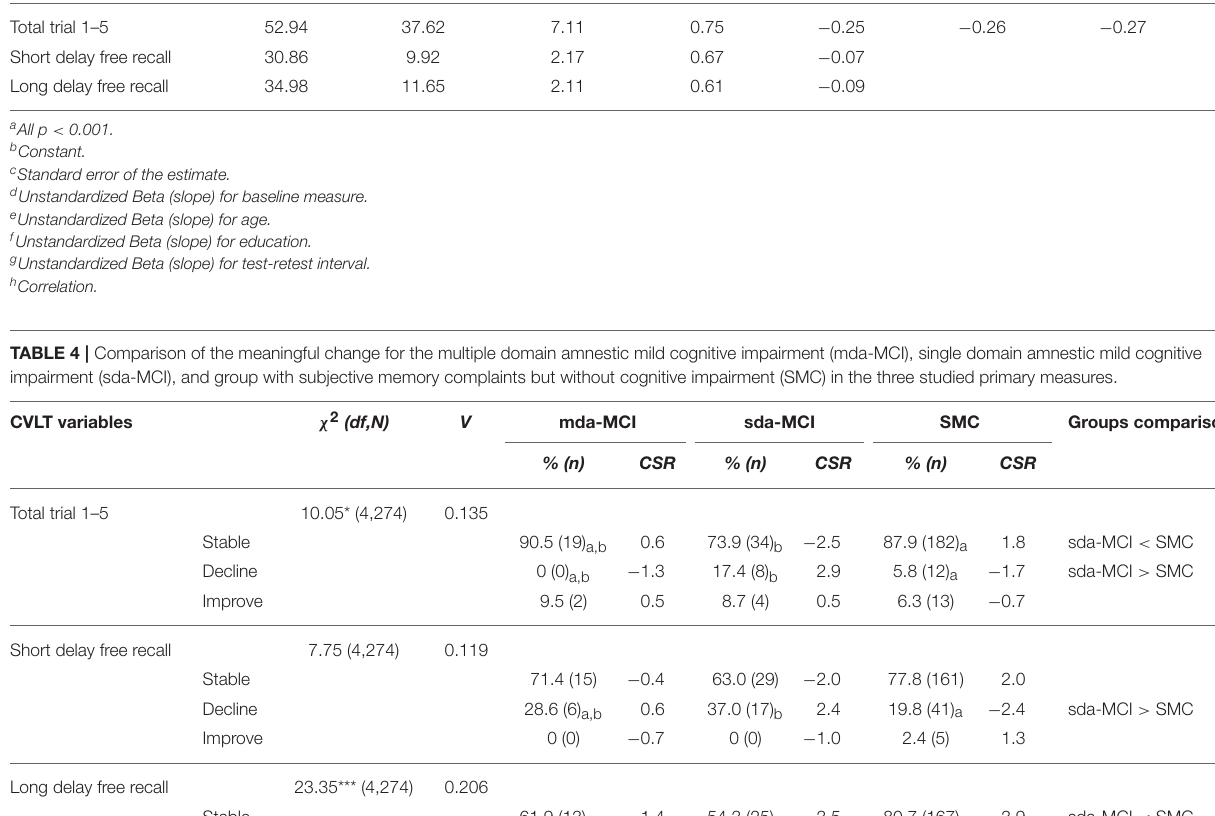
TABLE 3 | Regression coefficients and indices of significance for equations predicting follow-up scores for each of the three CVLT primary variables that showed homogeneous distribution in the group with subjective memory complaints but without cognitive impairment. CVLT variables F a